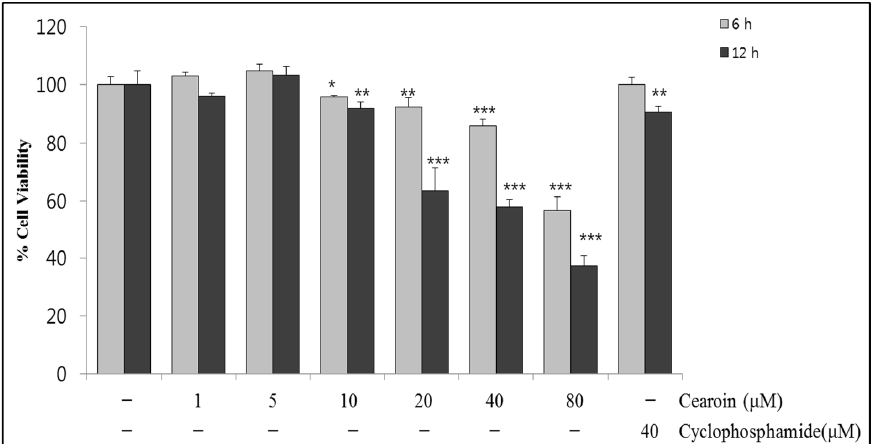
Figure 1. Cearoin reduces viability of human neuroblastoma SH-SY5Y cells. SH-SY5Y neuroblastoma cells were treated with cearoin in various concentrations (0, 1, 5, 10, 20, 40, or 80 μ M) and with 40 μ M cyclophosphamide as positive control and incubated for 6 h or 12 h. The cell viability was measured using MTT assay. Each bar represents the mean percentage alterations below control (±SD) ( n = 5~6). Differences were statistically significant at * p < 0.05, ** p < 0.01 and *** p < 0.001 as compared with the control.